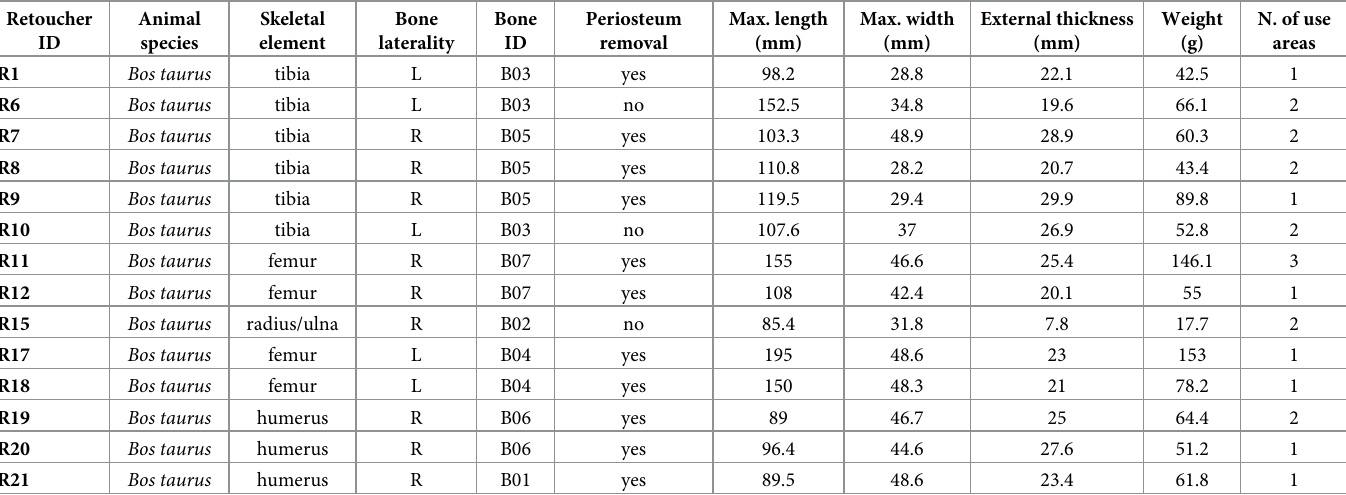
Table 1. Bone retouchers used during retouching session 1 (N =